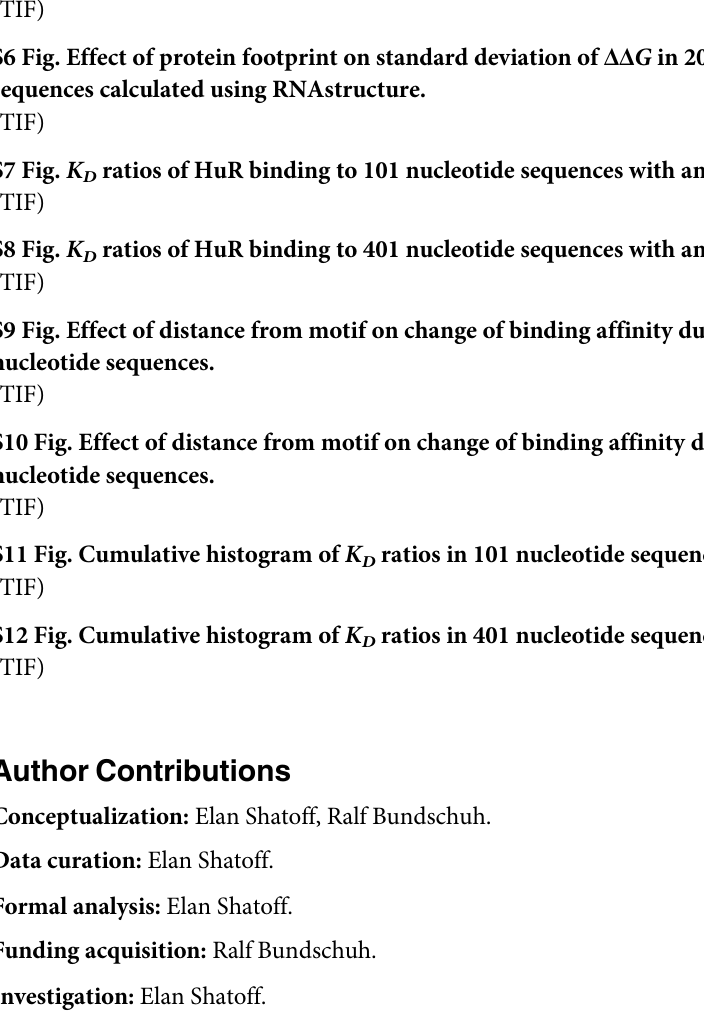
S2 Table. Effects of SNPs on HuR binding affinity in 101, 201, and 401 nucleotide sequences. (XLSX) S1 Fig. Effect of SNPs in random 101 nucleotide sequences on protein binding. (TIF) S2 Fig. Effect of SNPs in random 401 nucleotide sequences on protein binding. (TIF) S3 Fig. Effect of protein footprint on standard deviation of ΔΔ G in 101 nucleotide sequences. (TIF) S4 Fig. Effect of protein footprint on standard deviation of ΔΔ G in 401 nucleotide sequences. (TIF) S5 Fig. Effect of SNPs in random 201 nucleotide sequences on protein binding calculated using RNAstructure. (TIF) S6 Fig. Effect of protein footprint on standard deviation of ΔΔ G in 201 nucleotide sequences calculated using RNAstructure. (TIF) S7 Fig. K ratios of HuR binding to 101 nucleotide sequences with and without SNPs. D (TIF) S8 Fig. K ratios of HuR binding to 401 nucleotide sequences with and without SNPs. D (TIF) S9 Fig. Effect of distance from motif on change of binding affinity due to SNPs in 101 nucleotide sequences. (TIF) S10 Fig. Effect of distance from motif on change of binding affinity due to SNPs in 401 nucleotide sequences. (TIF) S11 Fig. Cumulative histogram of K ratios in 101 nucleotide sequences. D (TIF) S12 Fig. Cumulative histogram of K ratios in 401 nucleotide sequences. D